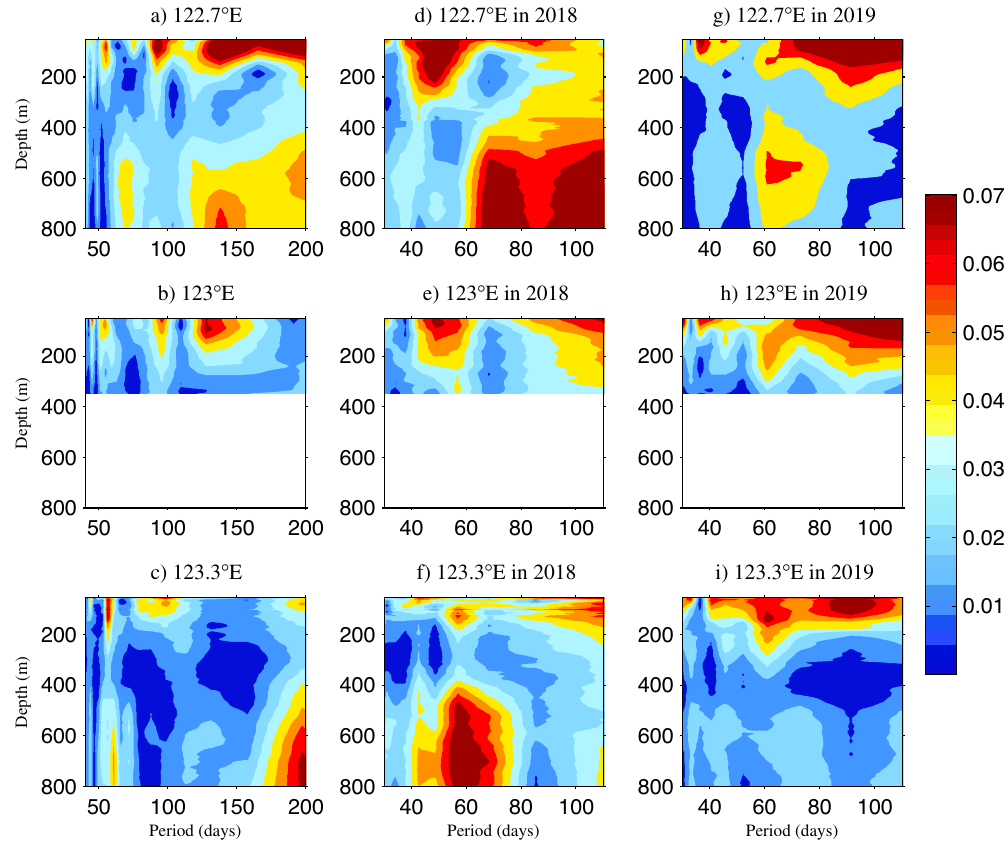
Figure 4. Power spectral density (PSD) of the meridional velocities during the whole observational period at ( a ) 122.7° E, ( b ) 123° E, and ( c ) 123.3° E, and during 2018 at ( d ) 122.7° E, ( e ) 123° E, and ( f ) 123.3° E, and during 2019 at ( g ) 122.7° E, ( h ) 123° E, and ( i ) 123.3° E along 18° N. Units are m 2 /(s 2 cycles per day [cpd]). Figures are plotted using MATLAB R2012b (http:// www. mathw orks.